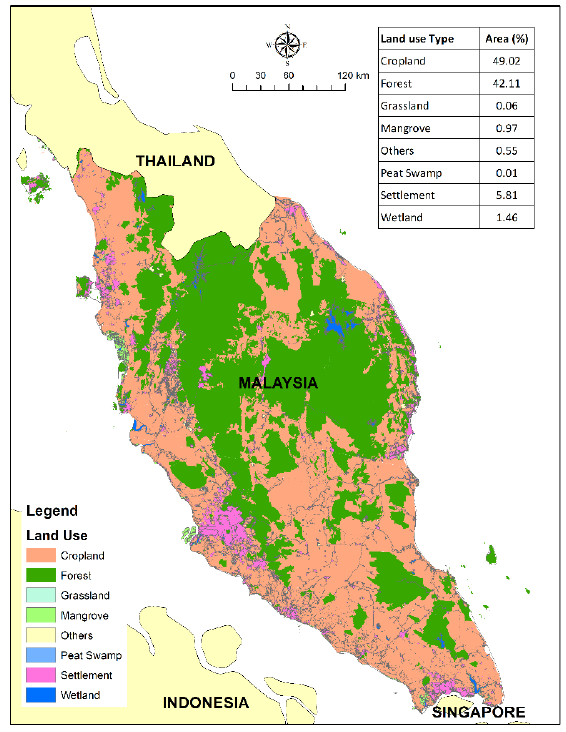
Figure 1. Land use map of Peninsular Malaysia.